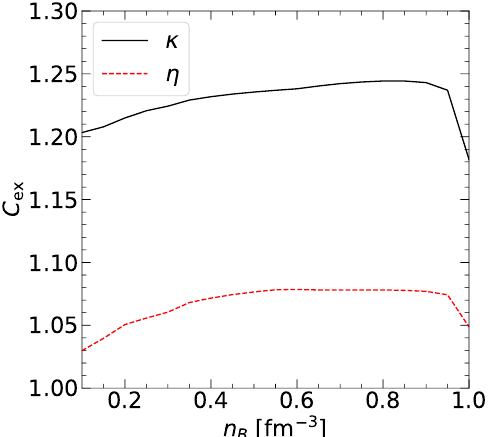
Figure 6. Corrections to the variational solution for the n Λ subsystem (obtained with the NSC97e model). Solid and dashed lines show correction coefficients for the thermal conductivity and shear viscosity cases,